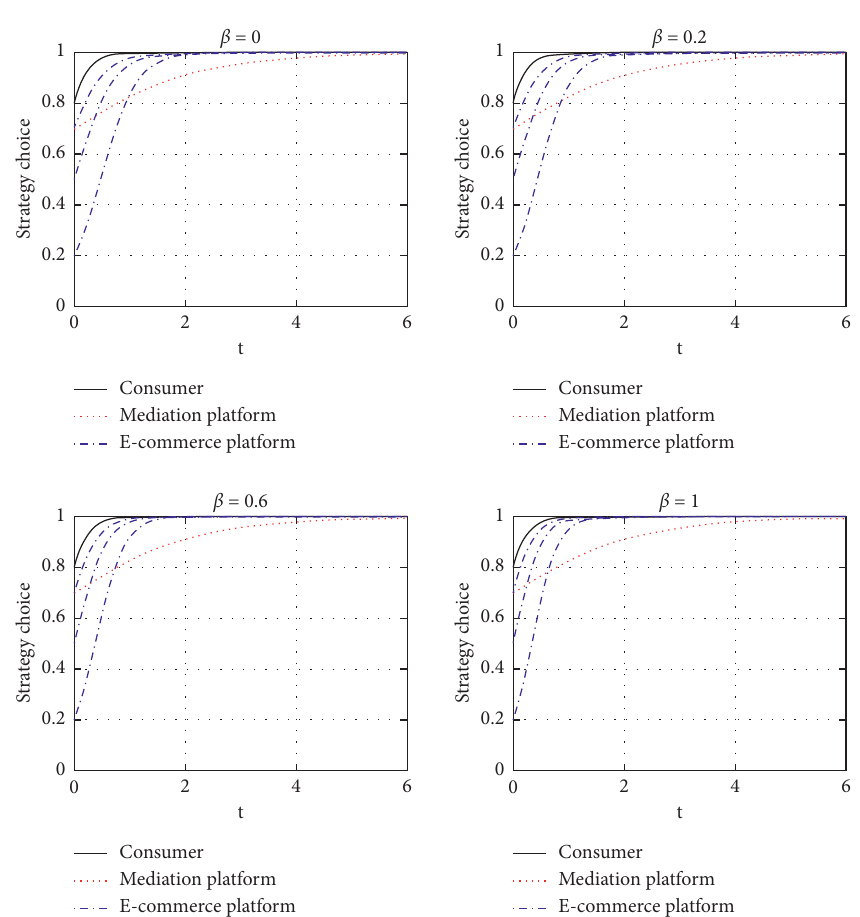
Figure 6: Influence of t the probability of consumer being dissatisfied with the outcome when the e-commerce platform is handled